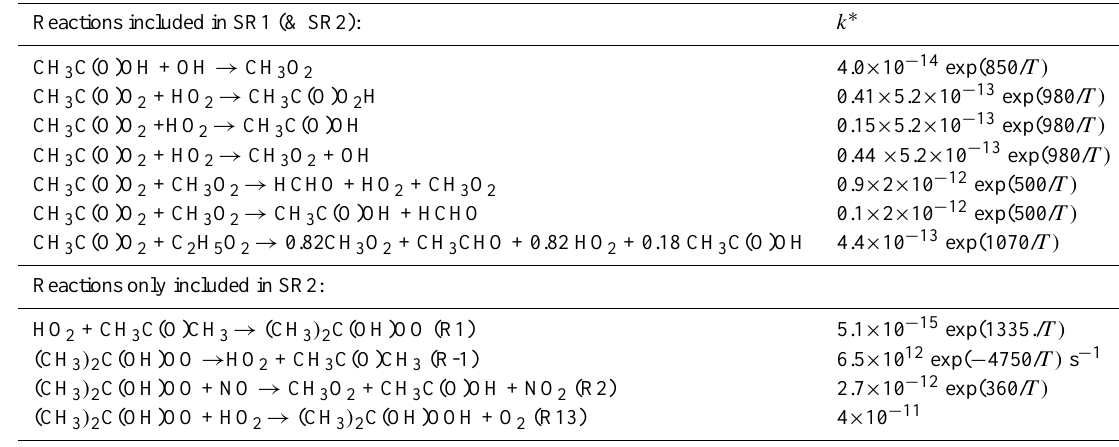
Table 1. Modifications to the chemical scheme used in the modelling studies. Reactions included in SR1 (& SR2):